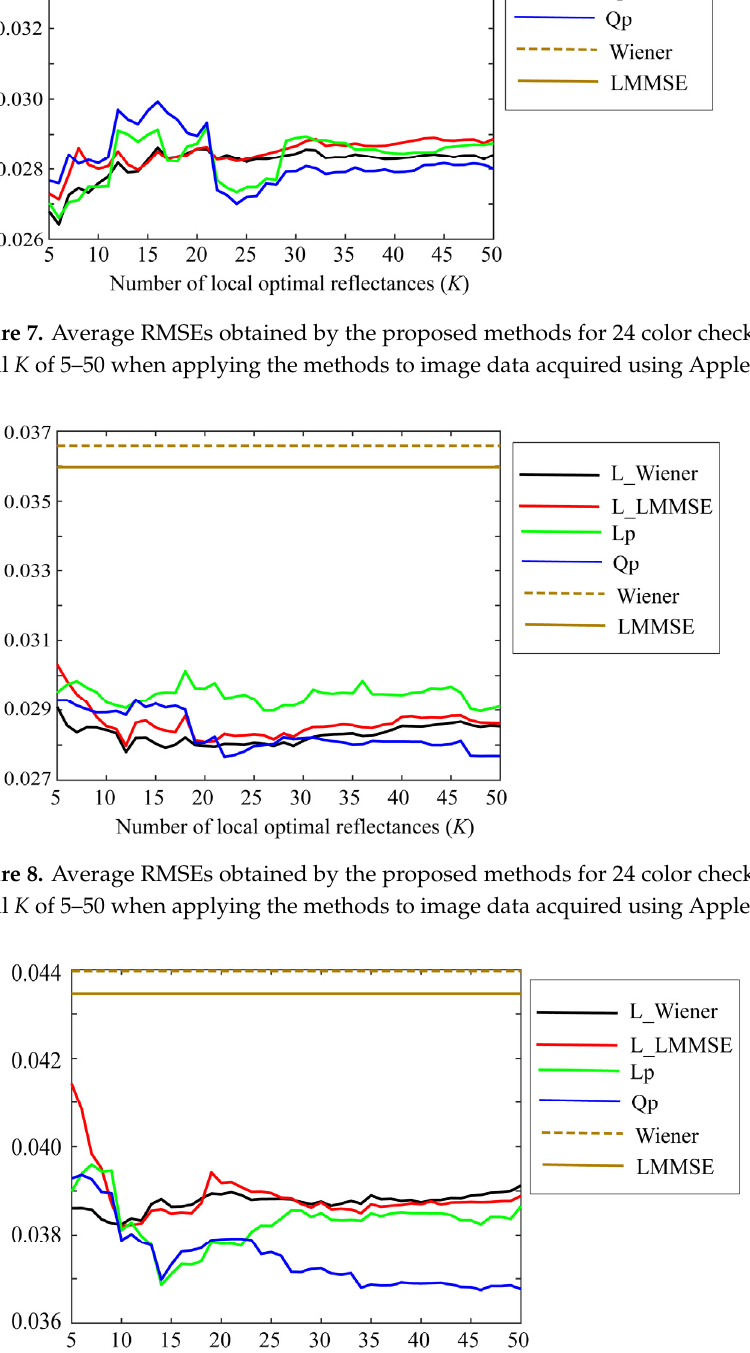
Figure 9. Average RMSEs obtained by the proposed methods for 24 color checkers in the range of small K of 5–50 when applying the methods to image data acquired using Huawei P10 lite.